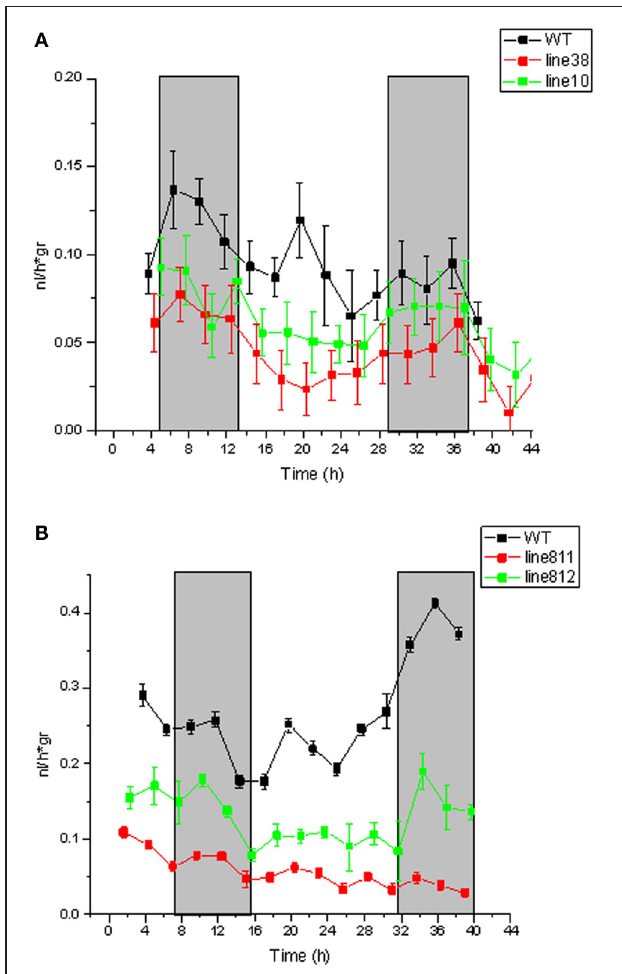
FIGURE A1 | Ethylene production in wild type Désirée and StSUT4-RNAi potato plants. Tissue cultured plants of wild type Solanum tuberosum tuberosum Désirée and corresponding StSUT4-RNAi lines #38, #10 (in A ) and two different plants of the transgenic line StSUT4-RNAi #81 (in B ) have been analyzed. Time is in h and the grey areas indicate the dark period during the experiment. Plant were grown under long day conditions (16h light, white light of 270 µ mol/m 2 × s, grey bars indicate dark periods). Ethylene production is given in nl per h per g fresh weight. Tested plants were kept 3–4 weeks in 2MS medium before ethylene measurement. Fresh weight of plants: A, WT 2.49g, StSUT4-RNAi #38 1.86g, StSUT4-RNAi #10 1.84g. B, WT 3.86g, StSUT4-RNAi #81.1 5.44g, StSUT4-RNAi #81.2 4.17g. StDev is